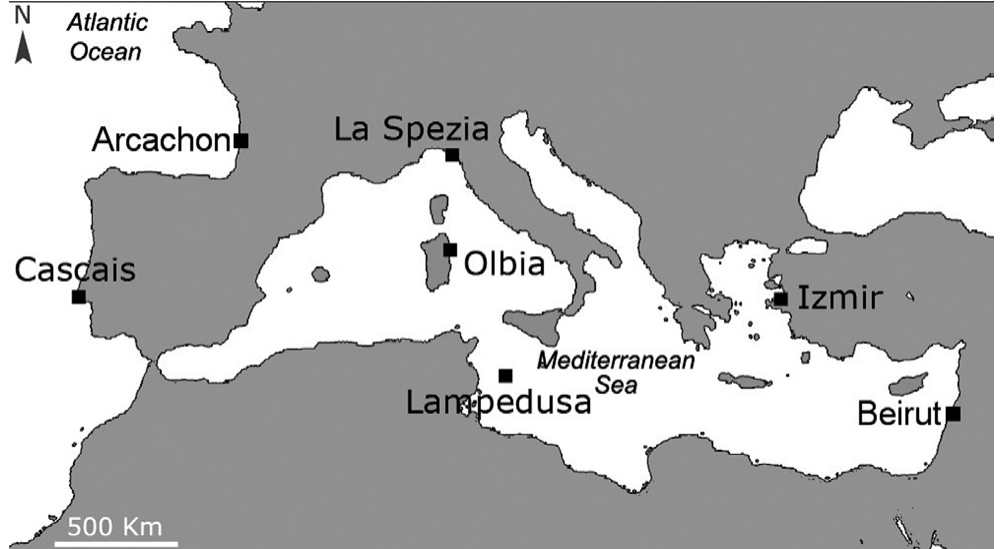
Fig. 1. – Location of the three Italian harbours investigated in the present study, La Spezia, Olbia and Lampedusa, and of the other Mediter- ranean and Atlantic sites where Celleporaria brunnea was detected.